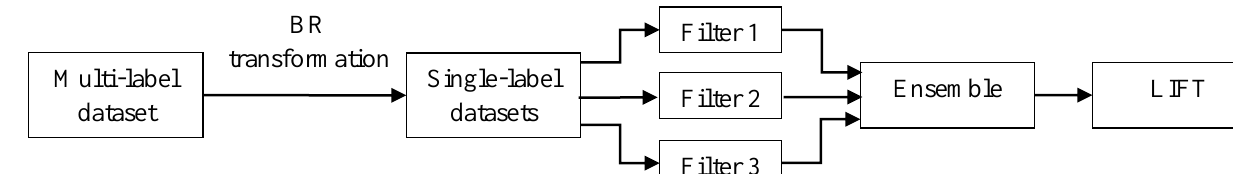
Figure 2. The diagram of the proposed system